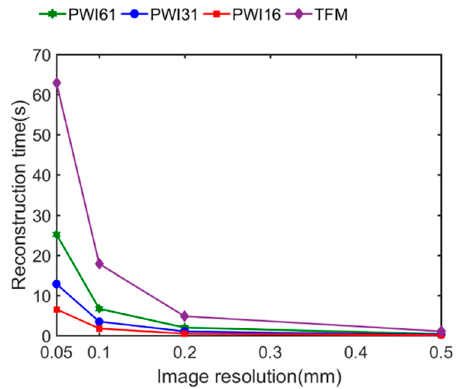
Figure 12. Reconstruction time in different resolutions via two algorithms.